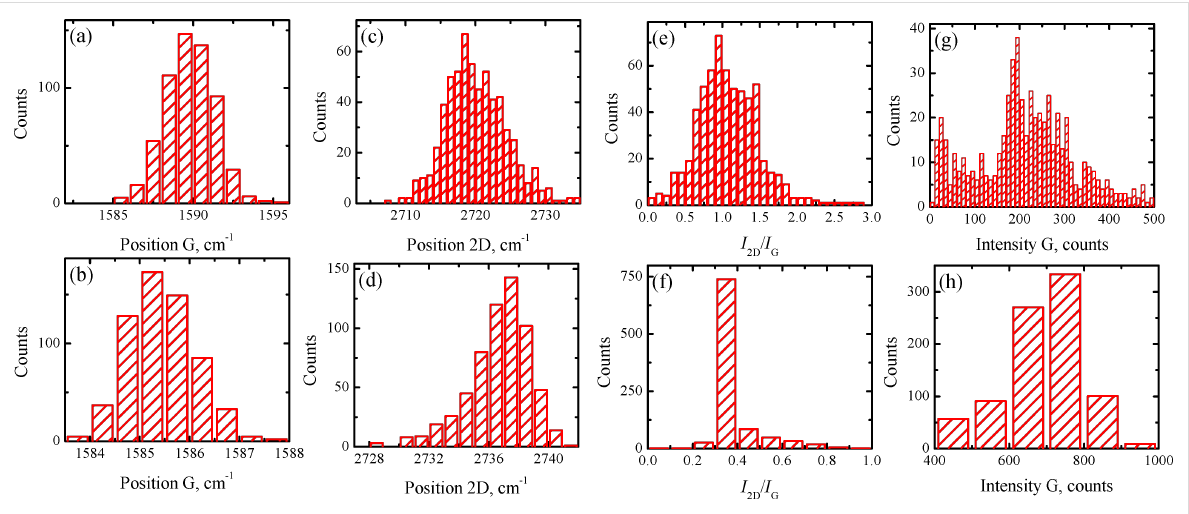
Figure 7: Replotted histograms of sample A on SiO 2 /Si substrate for laser excitation wavelength of 473 nm using 2D FWHM = 50 cm − 1 as the parti- tioning criterion. (a) and (b) G-band position. (c) and (d) 2D-band position. (e) and (f) I 2D / I G ratio. (g) and (h) I G value. Data shown in (a), (c), (e) and (g) plots are for 2D FWHM < 50 cm − 1 . Data shown in (b), (d), (f) and (h) plots are for 2D FWHM > 50 cm − 1 .